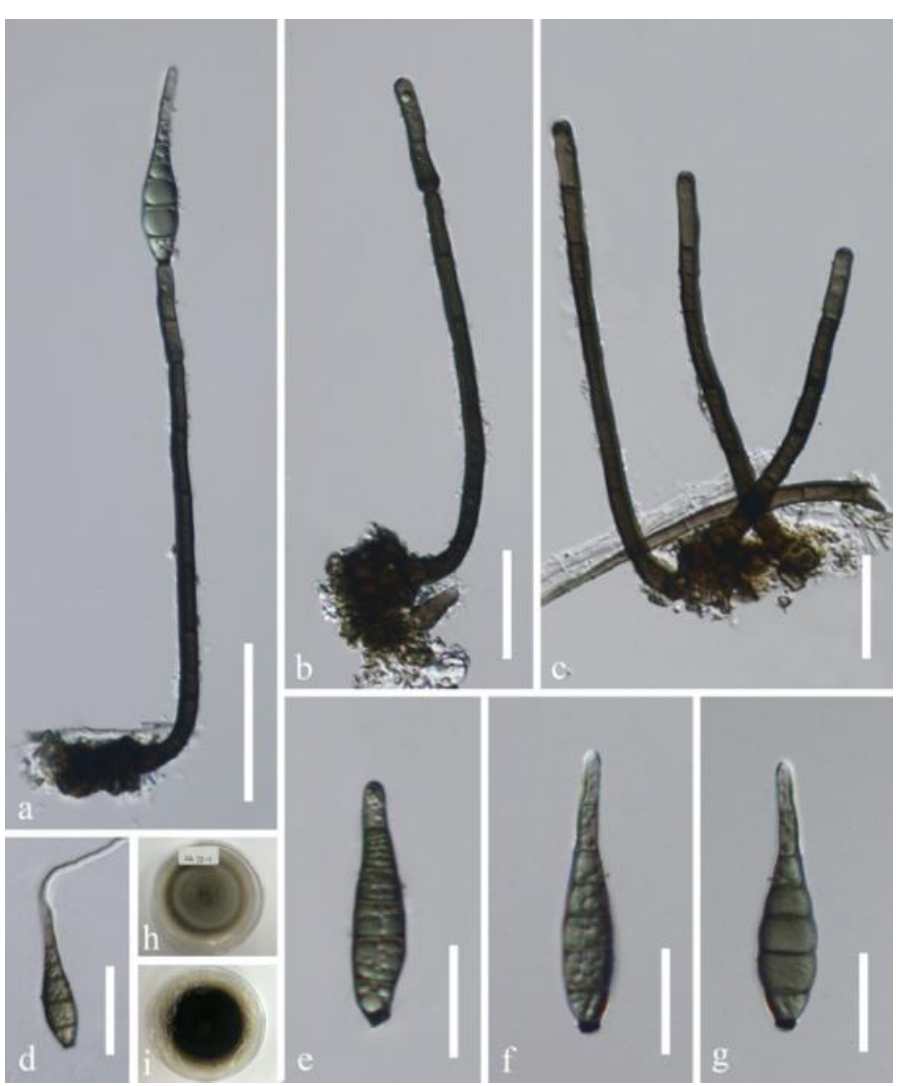
Figure 8. Distoseptispora verrucosa (HKAS 112652, holotype). ( a ) Conidiophore with a conidium. ( b,c ) Conidiophores. ( d ) Germinated conidium. ( e – g ) Conidia. ( h,i ) Culture, h from above, i from below. Scale bars: ( a ) 50 μm, ( b – d ) 30 μm, ( e – g ) 20 μm.